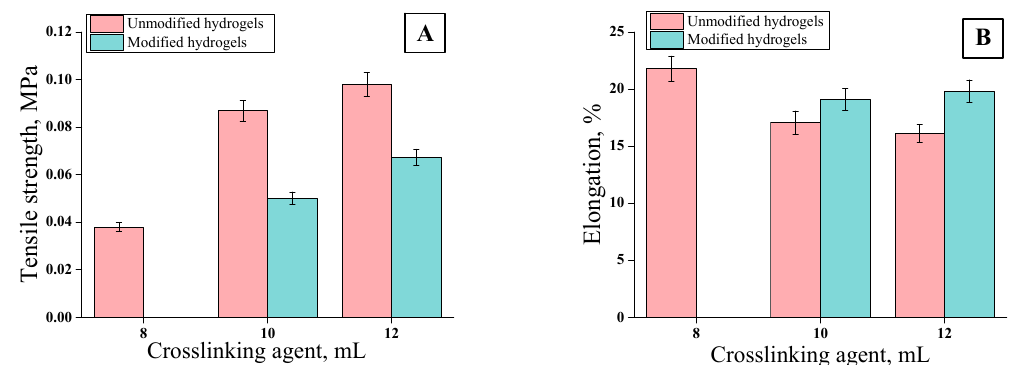
Figure 13. Results of strength analysis of materials modified and unmodified with di ff erent PEGDA 700 content: ( A ) Tensile strength (average value SD = 1.15%, number of repetitions n = 3), ( B ) percentage elongation (average value SD = 1.17%, number of repetitions n = 3).